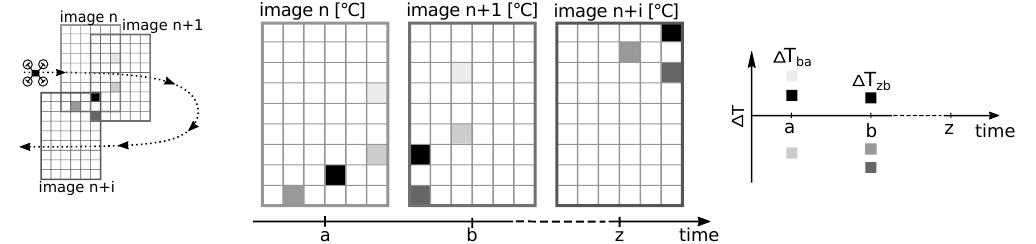
Figure 3. Scheme of tiepoint extraction and calculation of uncertainty measures. n = number of the